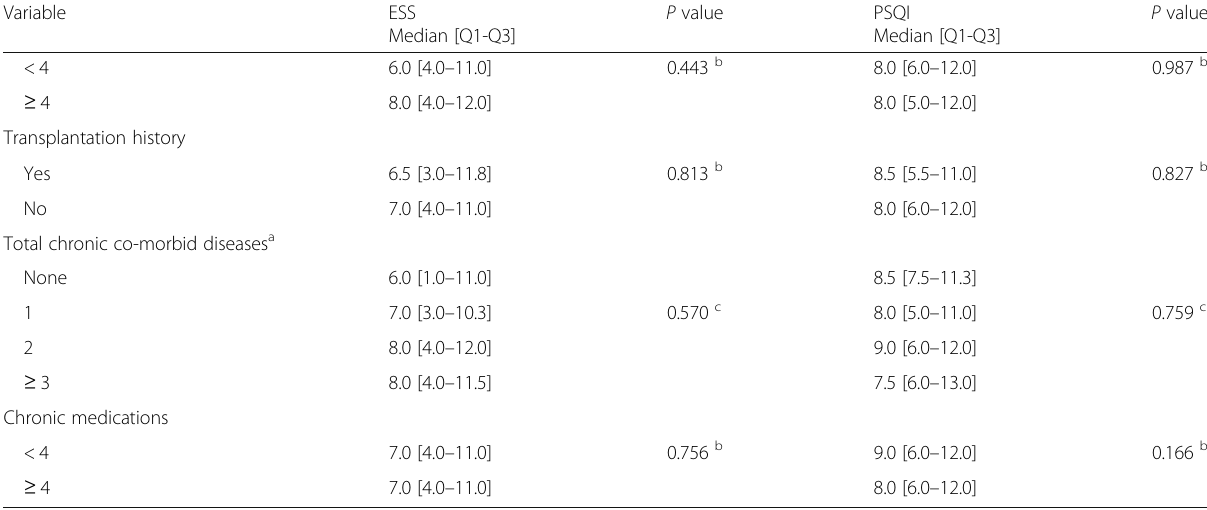
Table 2 Relationship between characteristics of participants and their Epworth sleepiness scale and PSQI scores (Continued)